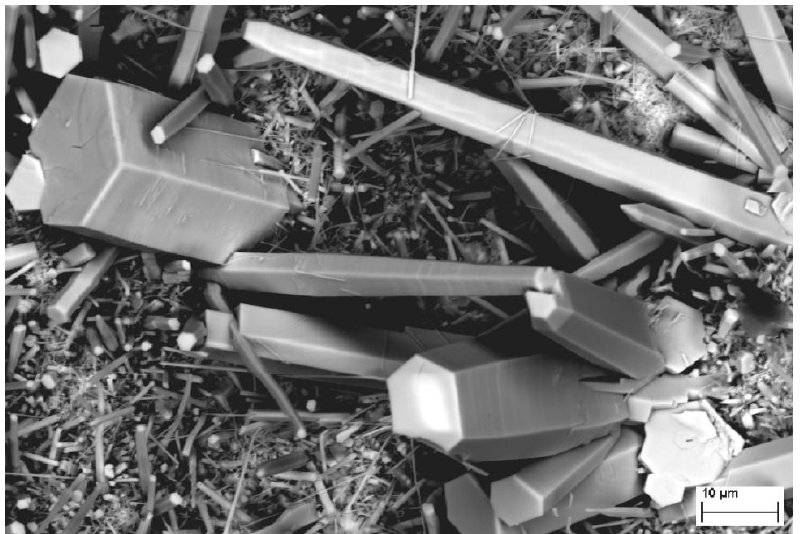
Figure 1. FE-SEM BSE image of hexagonal NaPb 2 (CO 3 ) 2 (OH) crystals grown on lead foil in Na 2 CO 3 solution (Photo: Dirk Kirchner).